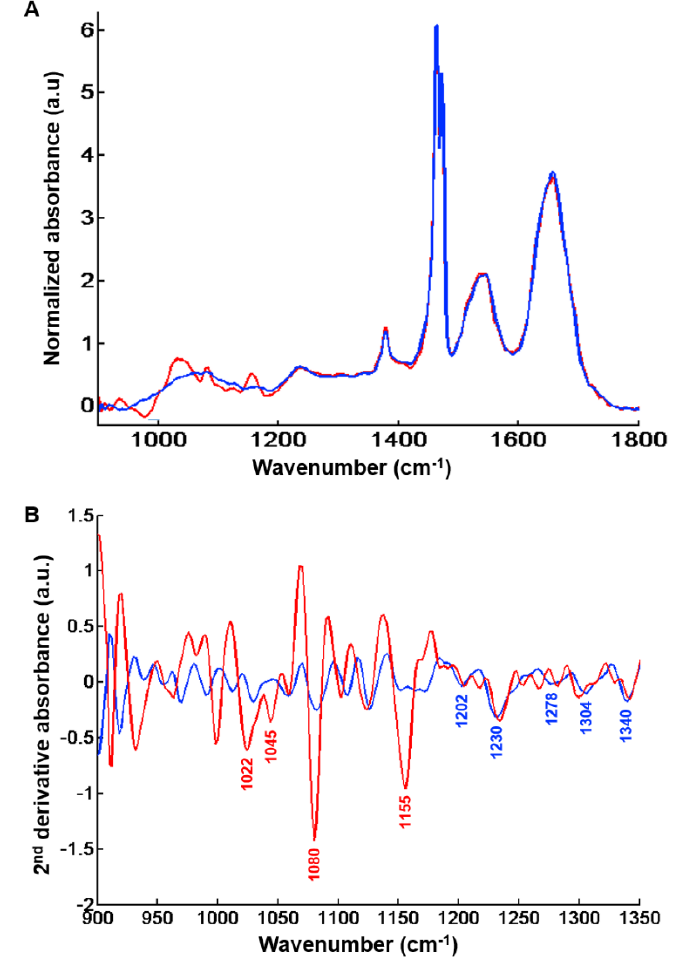
Figure 5. Centroids representative of regeneration nodules and hepatic fibrosis tissue after k-means clustering ( k = 2) of the spectral image shown in Figure 1C. ( A ) Centroid spectra representative of fibrosis regions (dark blue line) and regeneration nodules (red line) in the 900–1800 cm − 1 spectral range. ( B ) Second derivative of above centroid spectra and peak assignment with fibrosis (dark blue line) and regeneration nodules (red line) in the 900–1350 cm − 1 spectral range. Peaks that can be tentatively assigned to glycogen (regeneration nodules) and collagen (fibrosis tissue) are indicated in red and blue respectively. Results are from FTIR images acquired with a projected pixel size of 25 μm.